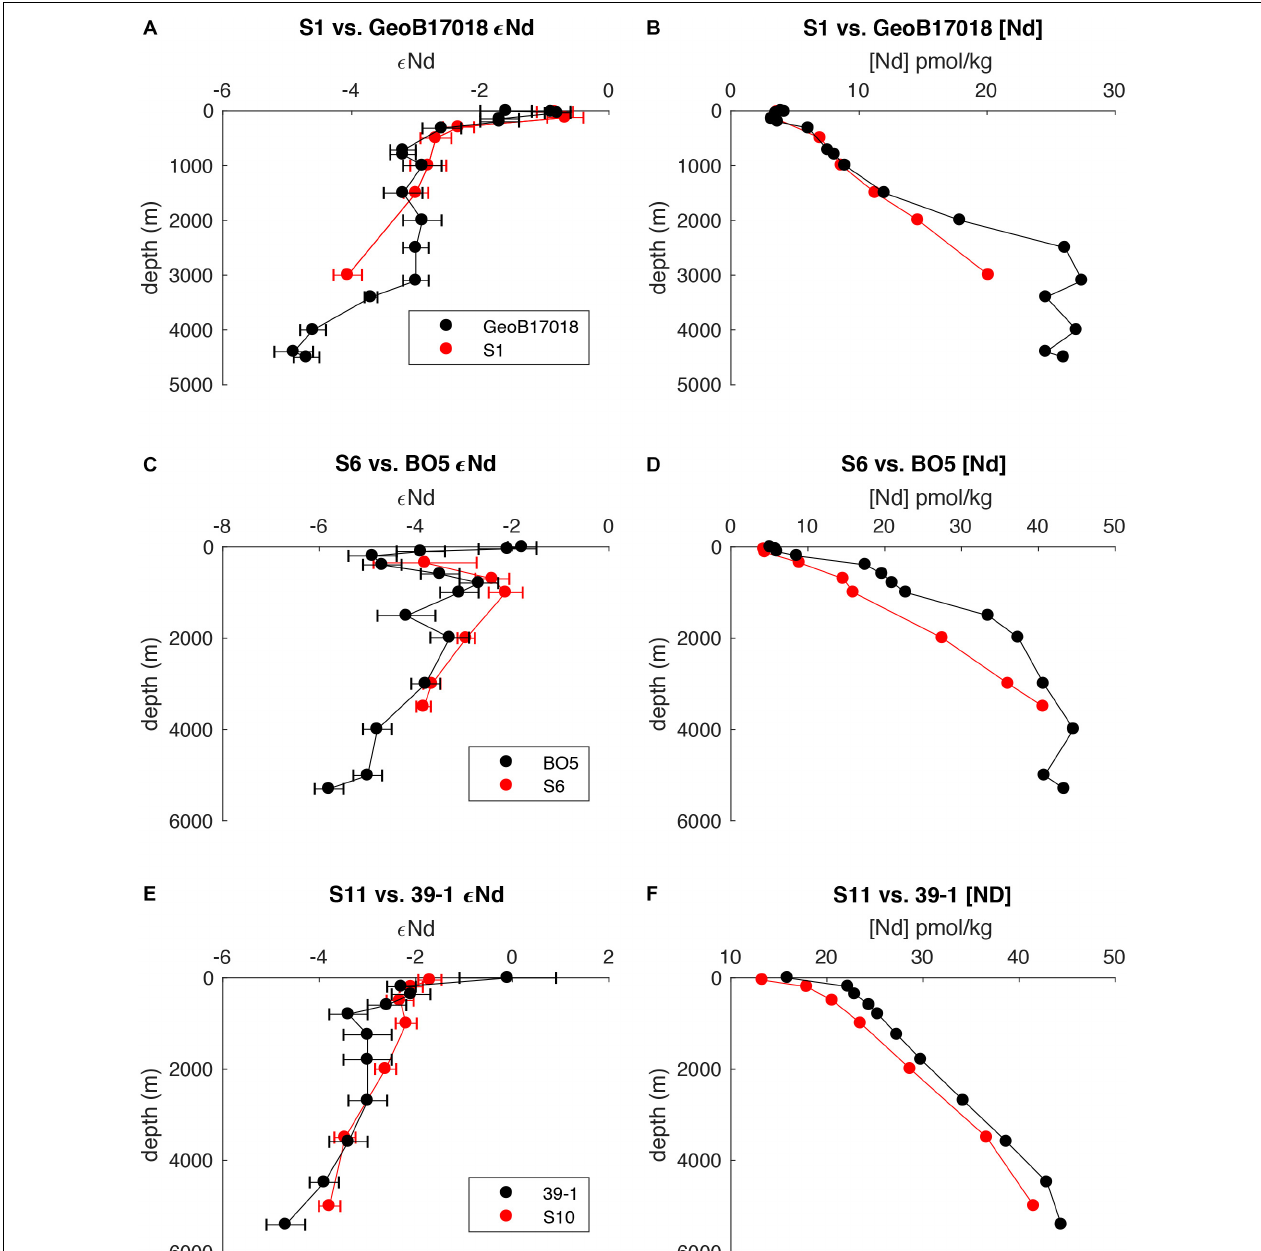
FIGURE 8 | Comparison between stations of this study and previously reported data from adjacent sites [Behrens et al., 2018 (A,B) ; Amakawa et al., 2009 (C,D) ; Piepgras and Jacobsen, 1988 (E,F)